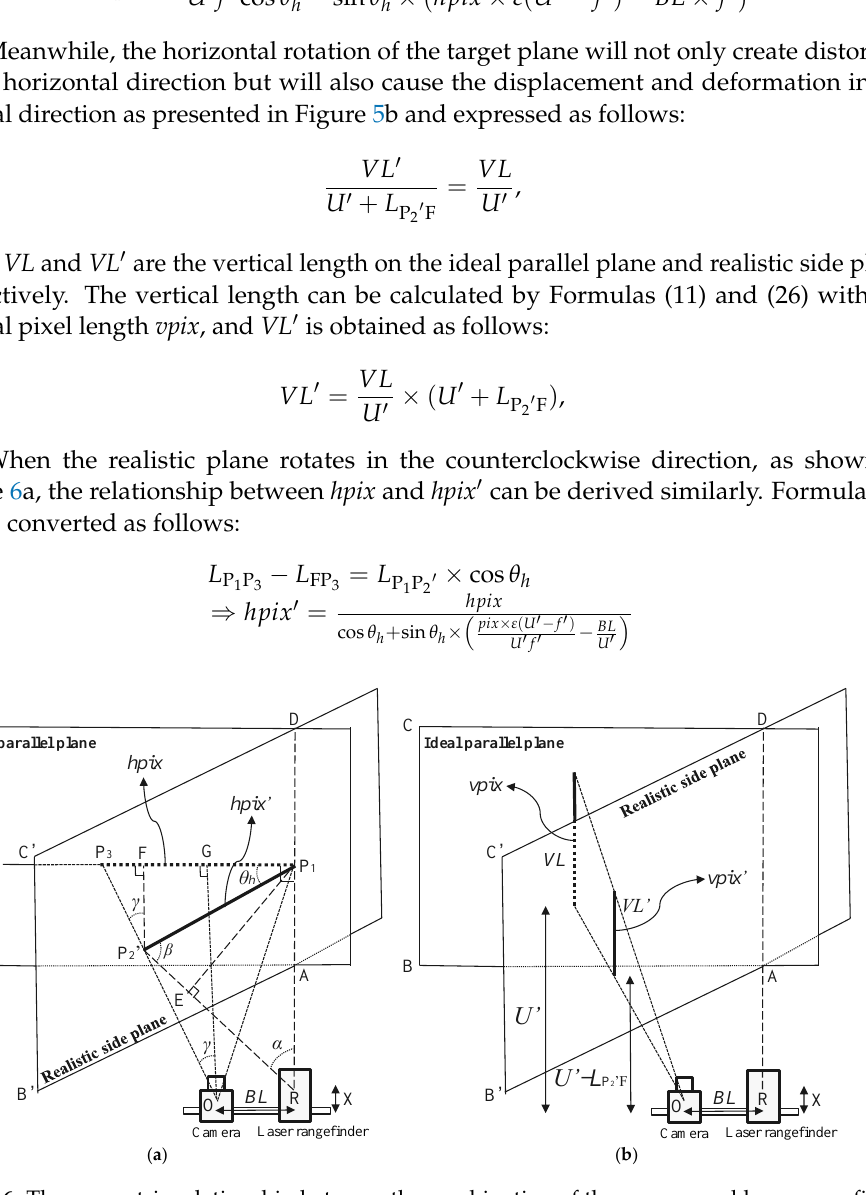
Figure 6. The geometric relationship between the combination of the camera and laser rangefinder and the target plane in counter-clockwise direction: ( a ) horizontal length transformation; ( b ) vertical proportional relationship.